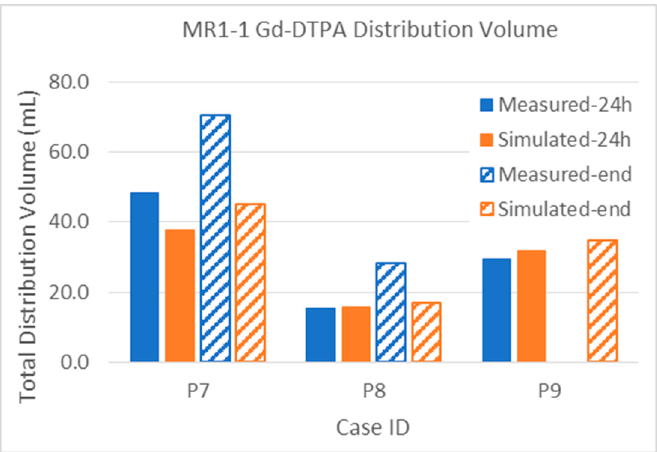
Figure 11. Comparison of measured and simulated Gd-DTPA distribution in MR1-1 patients. Total